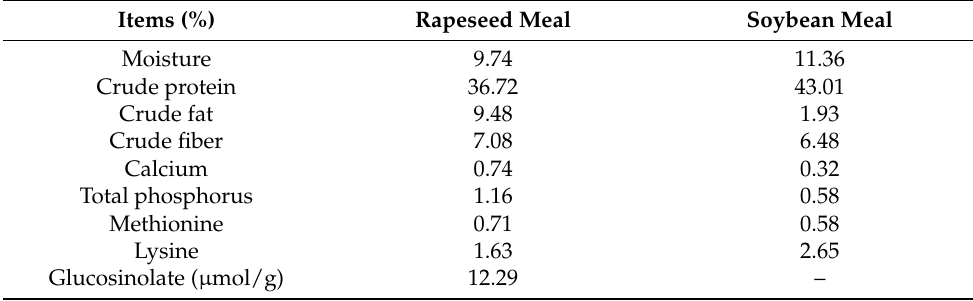
Table 1. Composition of rapeseed meal and soybean meal (air-dry basis) 1 .